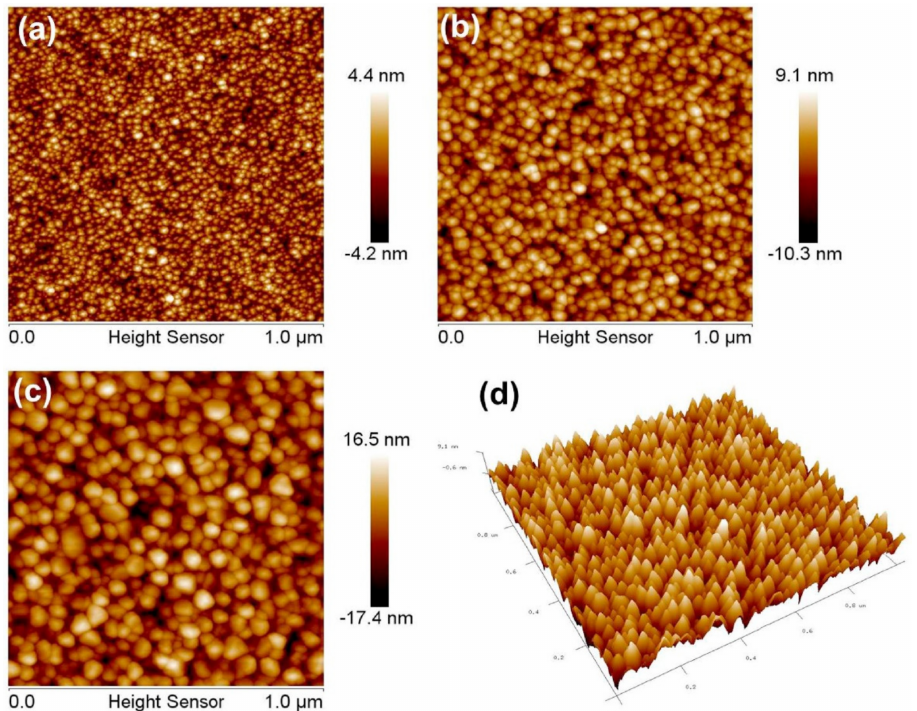
Figure 10. Surface morphology of NiO thin films dried at 250 ◦ C and annealed at: ( a ) 400 ◦ C, ( b ) 500 ◦ C, and ( c ) 600 ◦ C. ( d ) 3 − D image of film annealed at 500 ◦ C. Reprinted with permission from